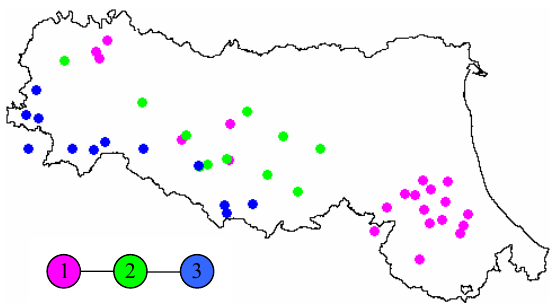
Fig. 6. Classification identified by discriminant analysis based on the first three PCs of the catchment